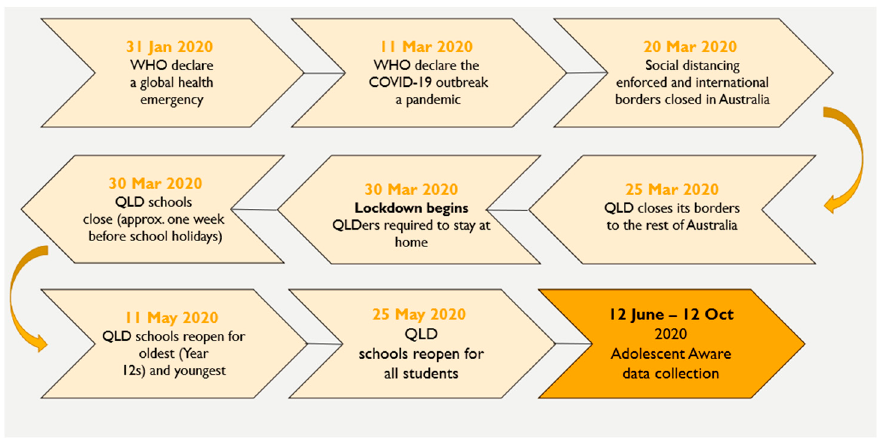
Figure 1. The 2020 Adolescent Aware data collection period in relation to school closure and social distancing policies of the 2020 COVID-19 pandemic in Queensland (QLD) Australia.